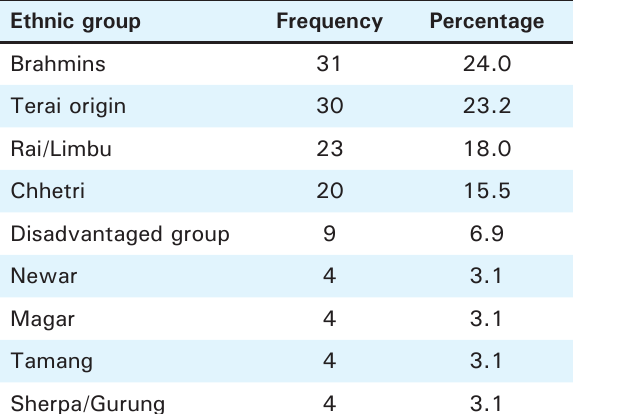
Table1. Demographic pro fi le of the study population